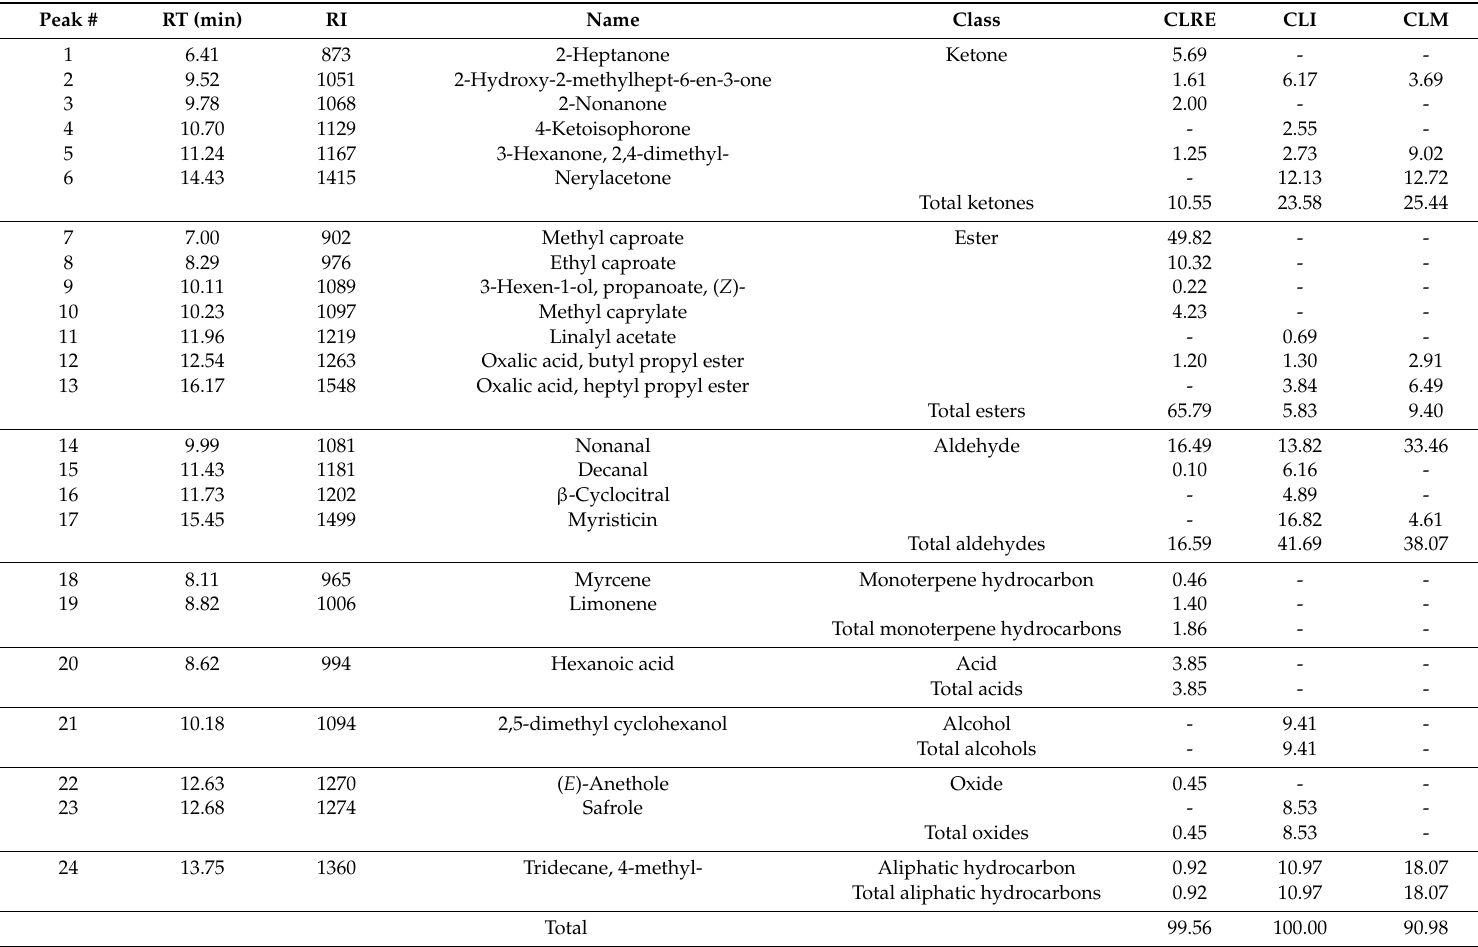
Table 2. Volatiles composition using solid phase micro-extraction (SPME) GC-MS of di ff erent origins (CLI) Indonesian ripe fruit, (CLM) Malaysian ripe fruit and (CLRE) Egyptian ripe fruit expressed as average relative